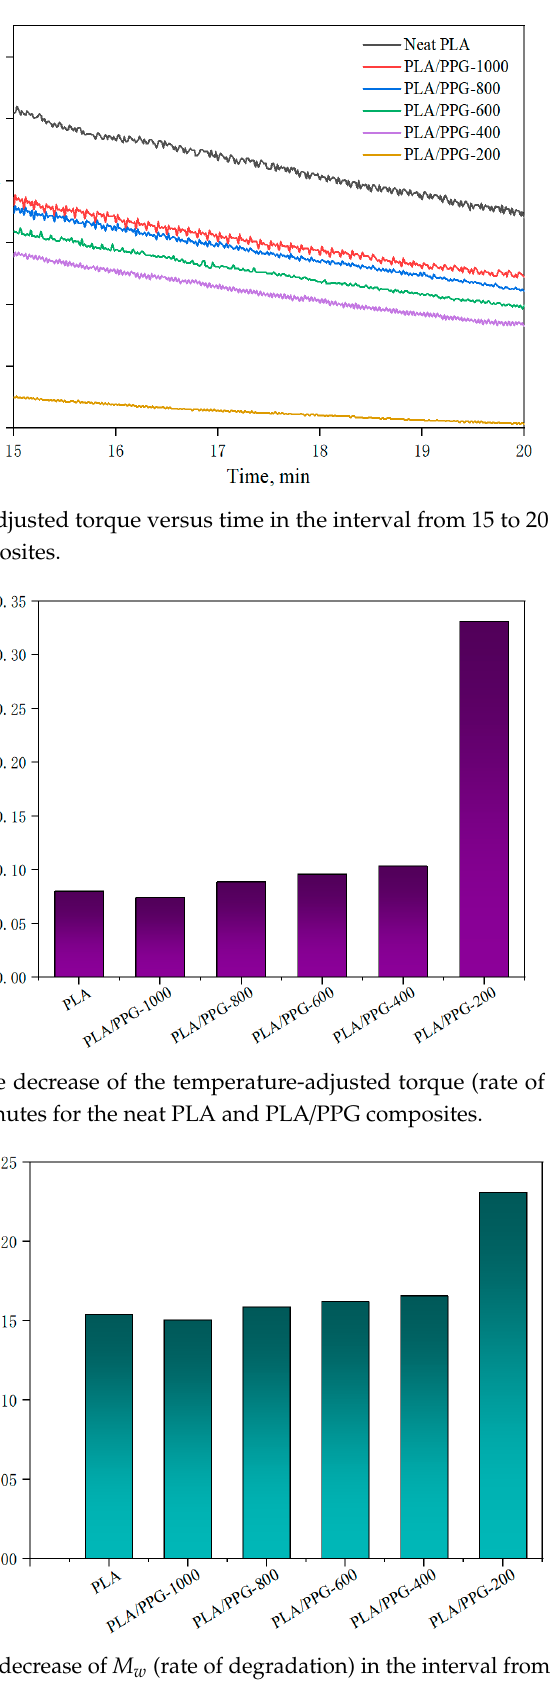
Figure 6. Rate of relative decrease of M w (rate of degradation) in the interval from 15 to 20 minutes for the neat PLA and PLA/PPG composites.